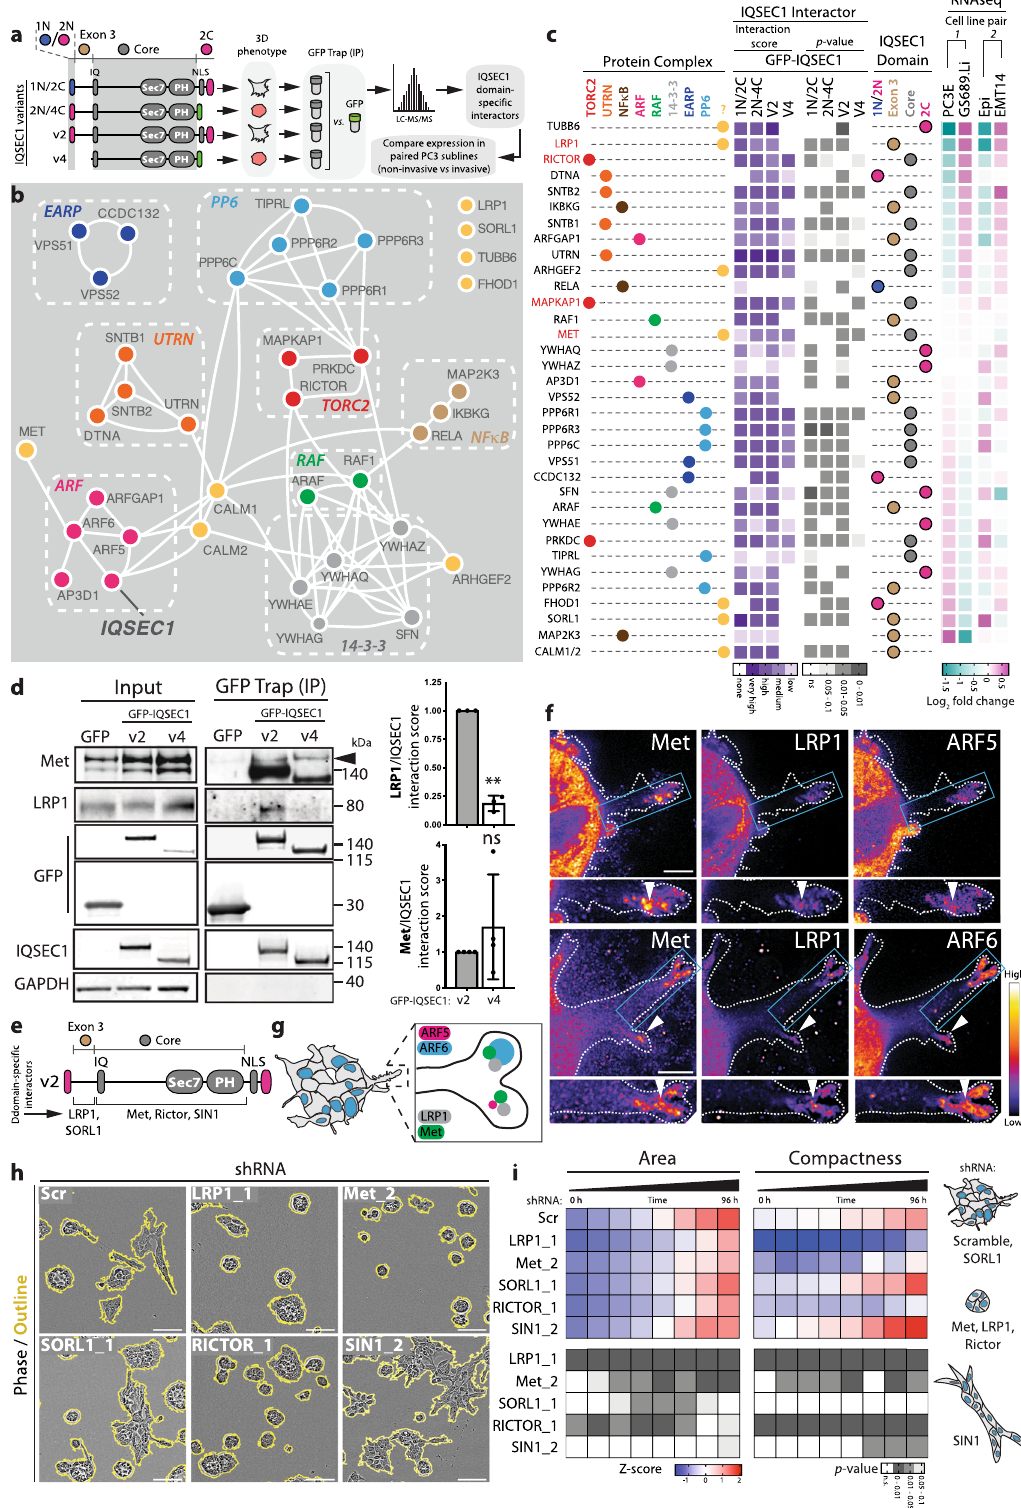
(Supplementary Fig. 7g – i). In contrast to PI3K inhibition, which decreases total and bulk peripheral levels of PIPs (Supplementary Fig. 7h, j), IQSEC1-depleted cells displayed an overall increase in total PI(4,5)P 2 and PIP 3 levels (Supplementary Fig. 7k), con- comitant with a decrease in bulk peripheral PIPs (Figs. 6a, S7c) and the appearance of PIPs in intracellular